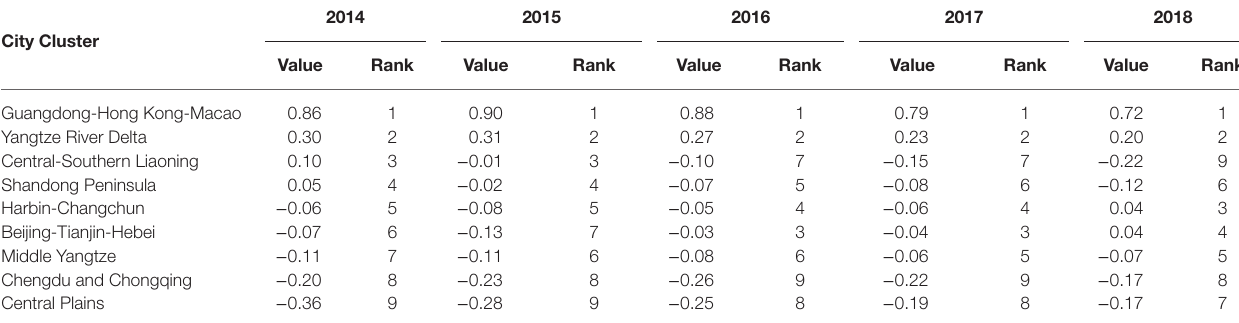
TABLE 4 | High-quality economic development in urban